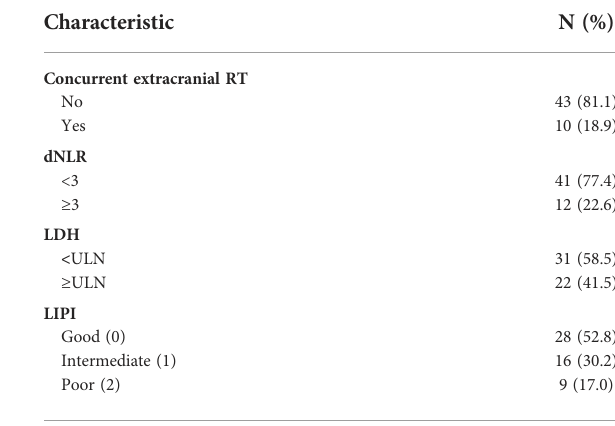
TABLE 1 Clinical characteristics of the study population.